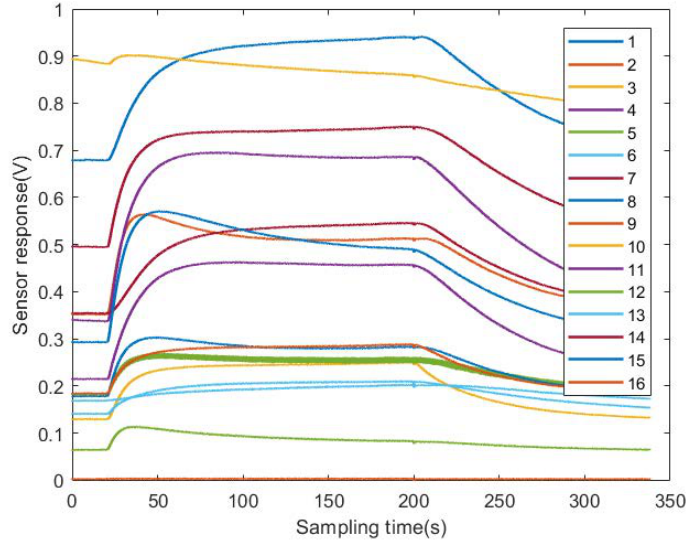
Figure 5. Sensor responses to Astragalus given by the E-nose system (voltage (V) versus time (0.01 s)).